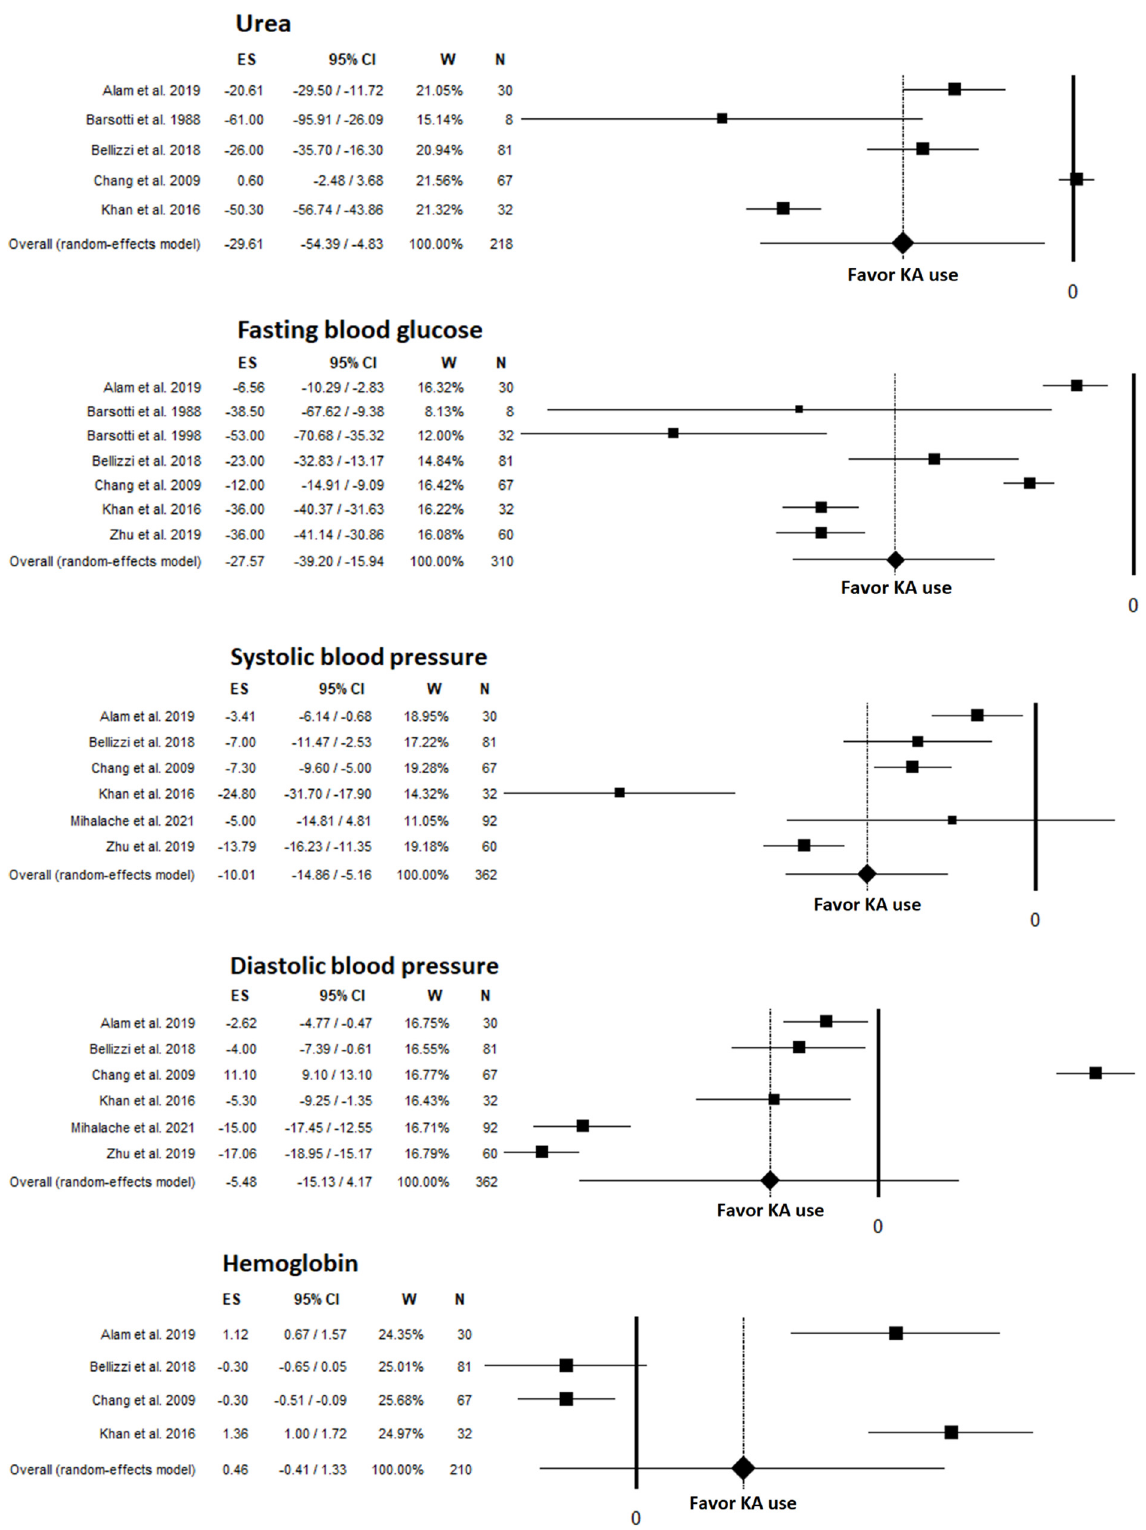
Figure 3. Meta-analyses for metabolic and clinical outcomes reported in studies included in the sys- tematic review; Urea [2,8,12,23,24], FBG [2,8,12,23–25,30], SBP [2,8,12,23,27,30], DBP [2,8,12,23,27,30], Hb [2,8,12,23]. KA, ketoanalogues.